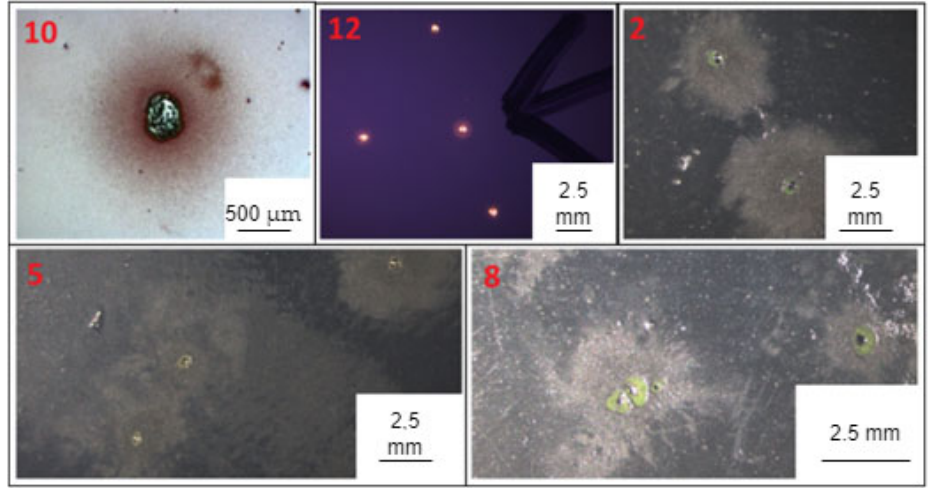
Figure 5. Wide spread homogeneity changes after electric discharge.